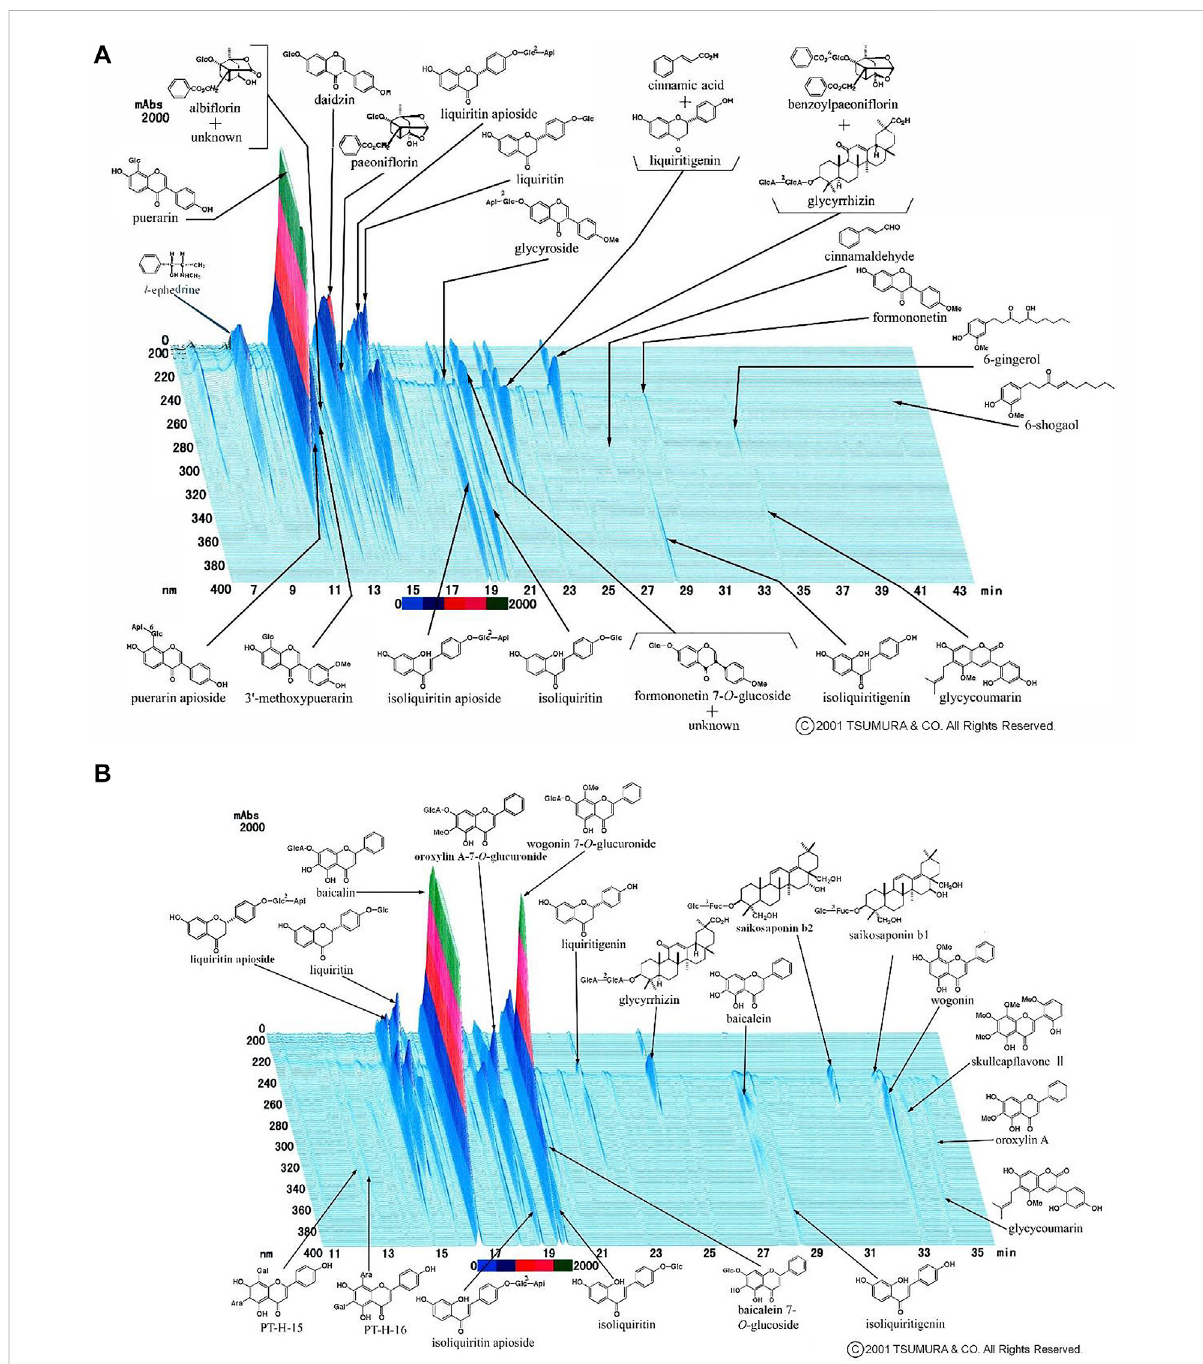
nine crude drugs: JP Bupleurum root, JP Scutellaria root, JP Ginseng, JP Pinellia tuber, JP Jujube, JP Ginger, JP Glycyrrhiza, JP Platycodon root, and JP Gypsum. The HPLC results for SSKKS are shown in Figure 1B. Detailed information of